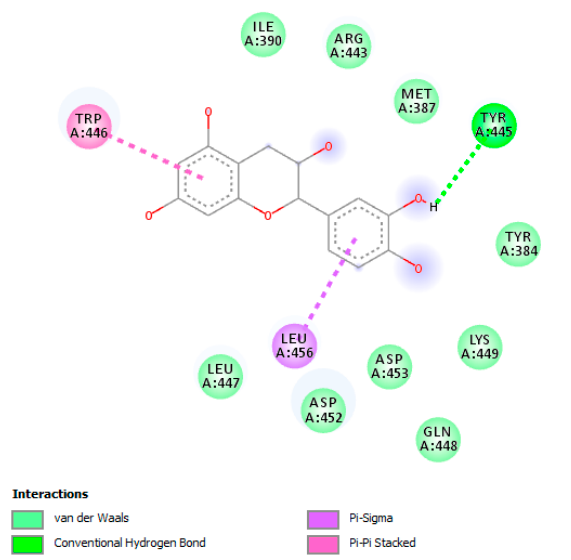
Figure 4. Putative interaction between catechin and the multidrug efflux system transporters of E. coli (mdtK) (PDB:3MKT). Free energy of binding ( Δ G) and affinity (Ki) are − 7.9 kcal/mol and 1.7 µM, respectively. Antibiotics 2020 , 9 , x